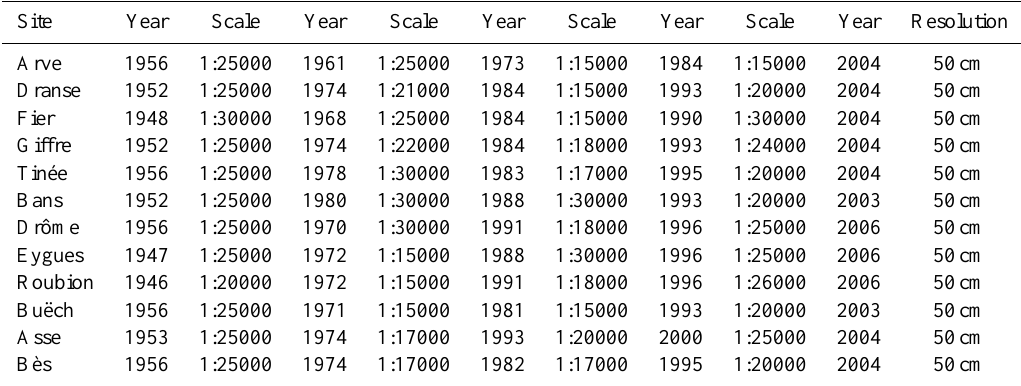
Fig. 1. Study area (A) , general characteristics of studied reaches (B) and hydrological regimes (C) . In (C) a monthly index is calculated as the ratio between the mean monthly flow and the mean annual flow, calculated for the set of stations. Reach characteristics are displayed in hydro-geographical groups: N = northern reaches (four reaches; the upper-Rhône); HM = high mountain reaches (two reaches; the upper Durance and the upper Var basins); W = south-western reaches (three reaches; the Rhône corridor); E = south-eastern reaches (three reaches; the Durance basin). Table 1. Summary of photo scales and years of survey for each of the studied